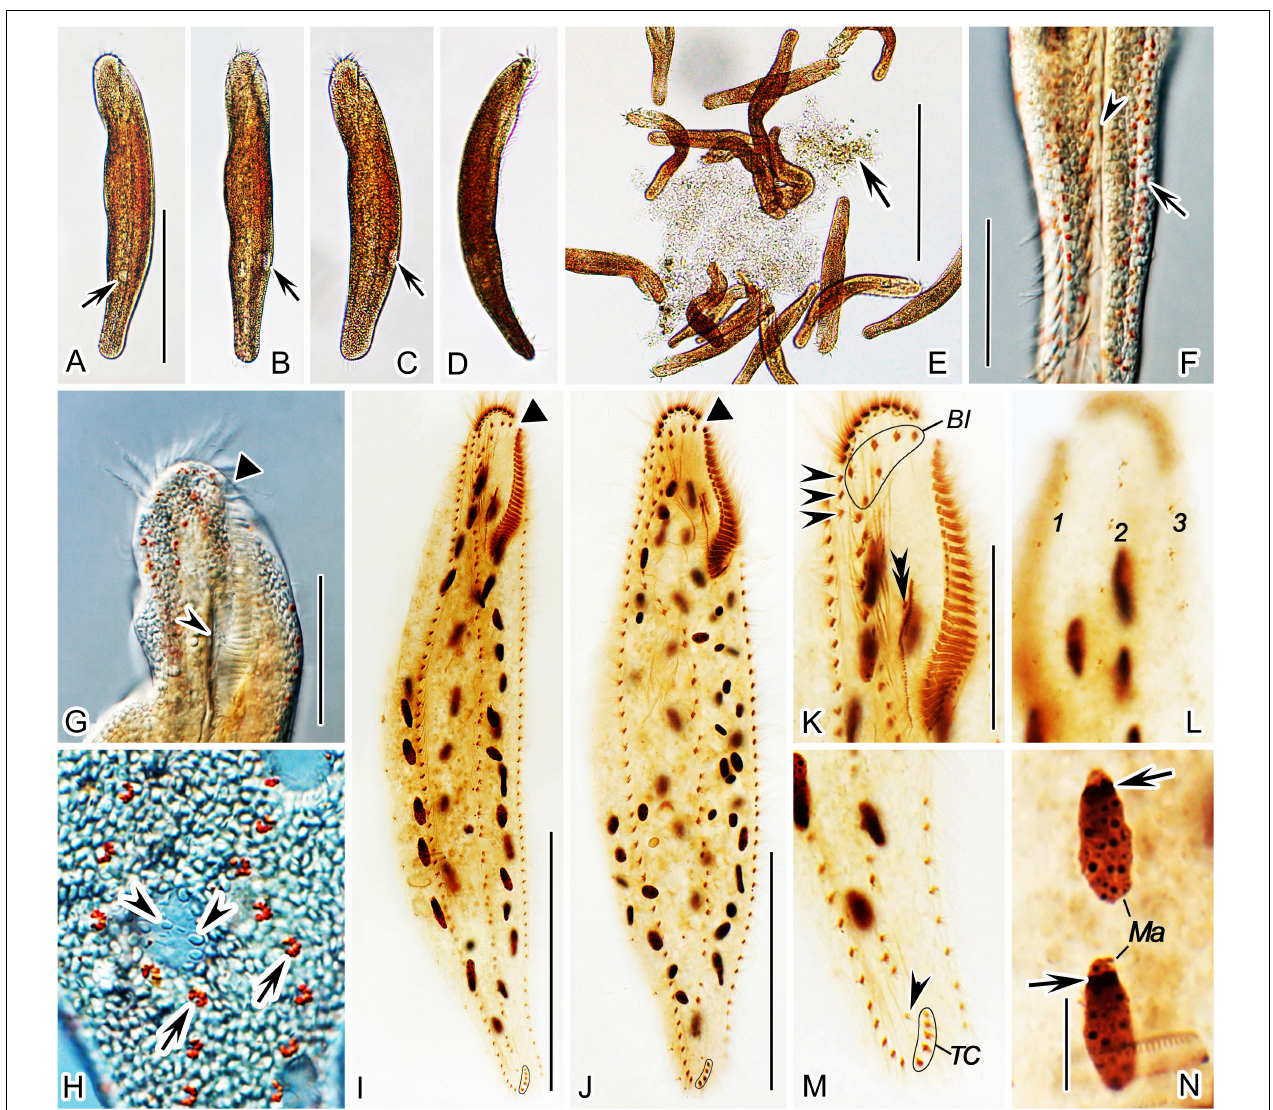
FIGURE 2 | Nothoholosticha luporinii n. sp. from life (A–H) and after protargol impregnation (I–N) . (A–D) Ventral (A–C) and lateral (D) overviews of different individuals, showing the body shape and the localization of the contractile vacuole (arrows in A–C ). (E) Free-foraging individuals, arrow indicates a mass of microalgae. (F) Ventral view of the posterior body portion, showing the red cortical granules (arrow) and the longitudinal groove along the midventral cirral complex (arrowhead). (G) Ventral view of the anterior body portion, showing the gap between the two parts of the adoral zone (triangle) and the buccal cavity (arrowhead). (H) Dorsal surface view, showing the arrangement of colourless (arrowheads) and bright red (arrows) cortical granules. (I,J) Ventral view of the holotype (I) and the paratype (J) specimen, showing the ciliary pattern and the nuclear apparatus. Triangles mark the gap between the two parts of the adoral zone of membranelles. (K,L) Ventral (K) and dorsal (L) views of the anterior body portion of the same specimen. Arrowheads in (K) indicate the frontoterminal cirri, double-arrowhead shows the buccal cirrus. (M) Ventral view of the posterior body portion, arrowhead denotes the single pretransverse cirrus. (N) Details of the macronuclear nodules, arrows mark replication bands. BI, bicorona; Ma, macronuclear nodules; TC, transverse cirri; 1–3, dorsal kineties. Scale bars = 5 µ m (N) , 35 µ m (G,K–M) , 100 µ m (A–D,I,J) , and 200 µ m (E)